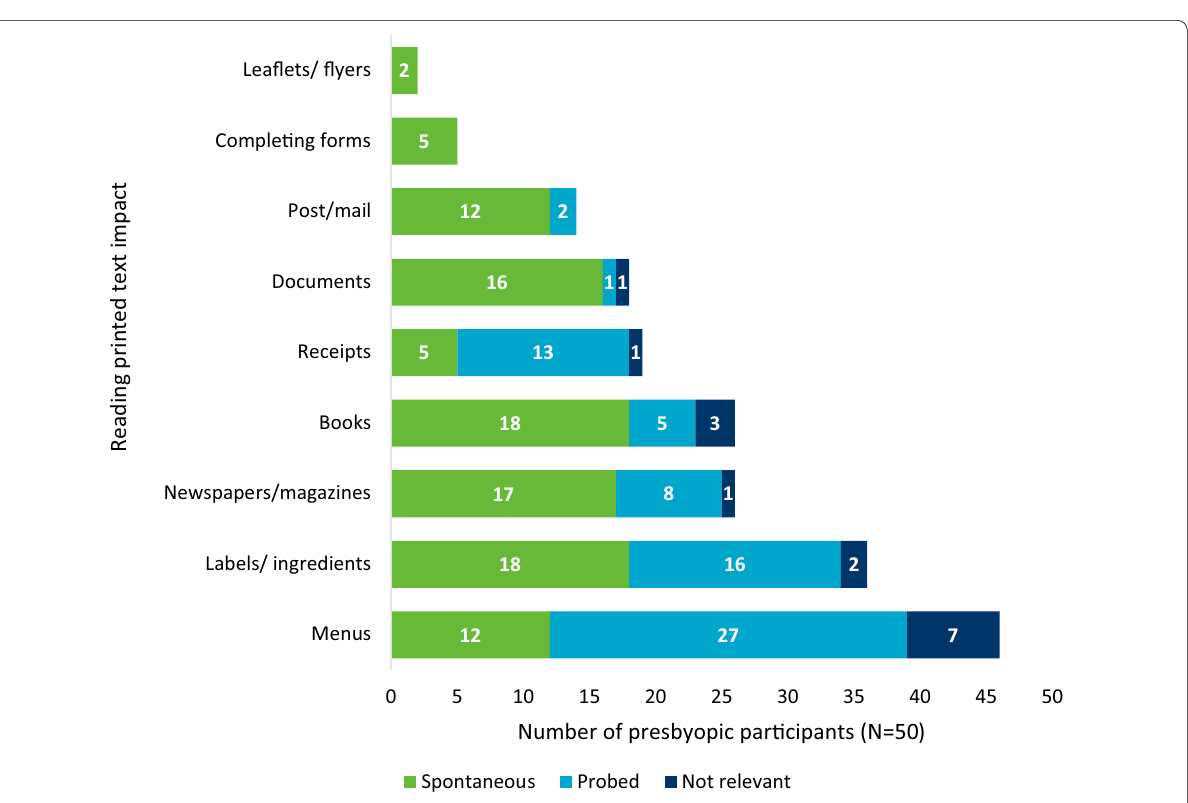
Fig. 3 Reading printed text impacts reported by individuals with phakic